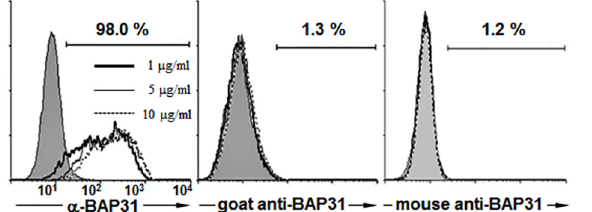
Fig 6. Flow cytometric analysis of the percent expression of cell surface-expressed BAP31 on H9 hESCs. The cell surface expression of BAP31 was examined by flow cytometric analysis with various concentrations (1, 5, or 10 μ g/ml) of rabbit (residues 165 – 246), goat (residues 125 – 158), or mouse (residues 137 – 161) anti-BAP31 antibodies. Shown are the percentages of BAP31-positive cells at the concentration of 10 μ g/ml of antibodies.